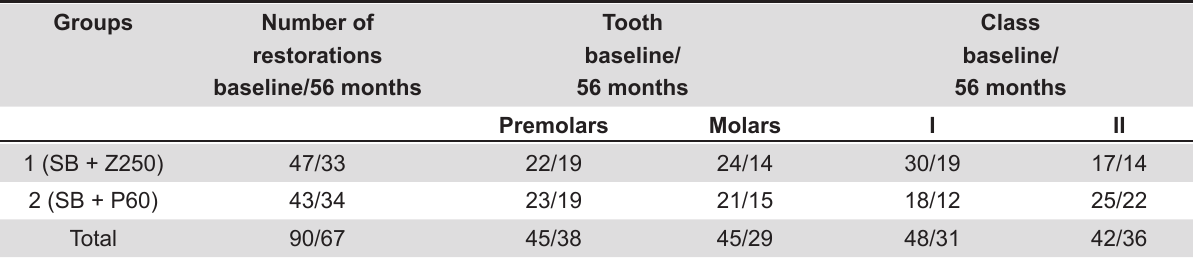
Table 1- Number of restorations evaluated at baseline and after 56 months by tooth location and extension (class) into different study groups